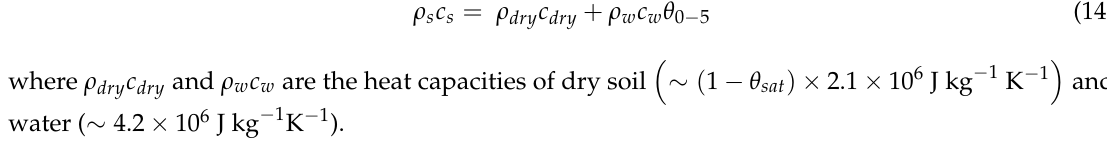
Table 1. Leaf parameters used in the PROSPECT model and the emissivities of the components in the ASTER bands. Parameter Leaf (Maize) Soil Wall Roof